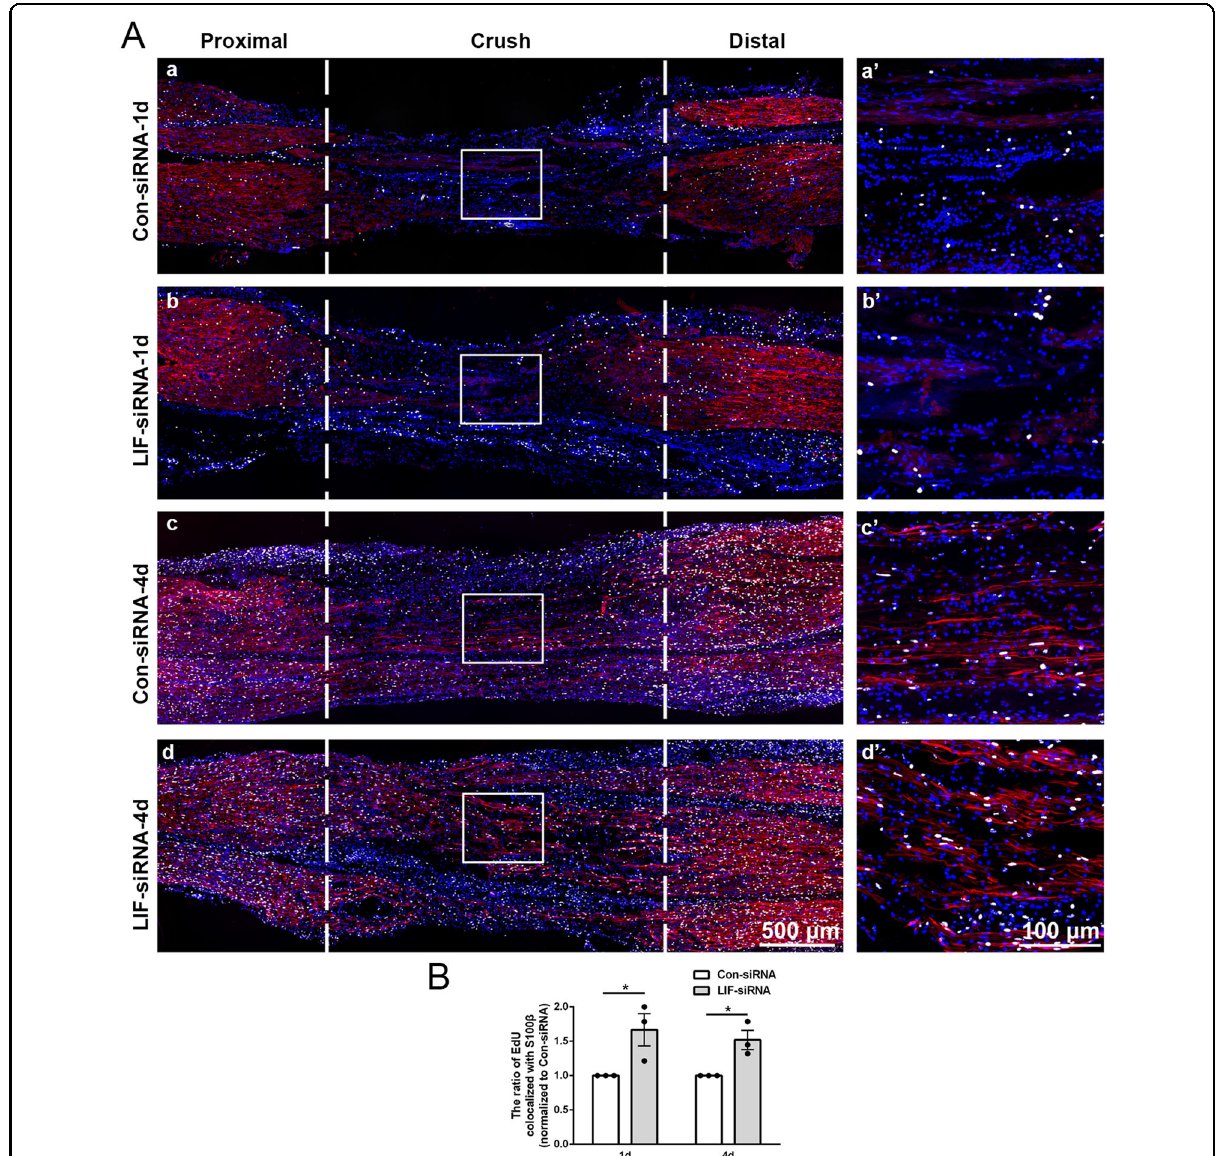
Fig. 2 LIF-siRNA promotes Schwann cell proliferation in vivo. A Representative immunostaining images of sciatic nerve longitude sections of rats injected with control-siRNA or LIF-siRNA. Rat sciatic nerve segments are collected at (a and b) 1 day and (c and d) 4 days after nerve crush injury. Injured areas (proximal segments, crush sites, and distal segments) are labeled with dashed lines. White color indicates Ki67 staining of proliferating cells, red color indicates S100 β , and blue color indicates nucleus. Boxed areas are demonstrated at a higher magni fi cation on the right. Scale bars indicate 500 μ m in main images and 100 μ m in magni fi ed images. B Quanti fi cation of the relative number of proliferating Schwann cells in rats injected with control-siRNA or LIF-siRNA at 1 day and 4 days after nerve crush injury. Data were presented as means ± SEM. * p value <0.05 versus control-siRNA